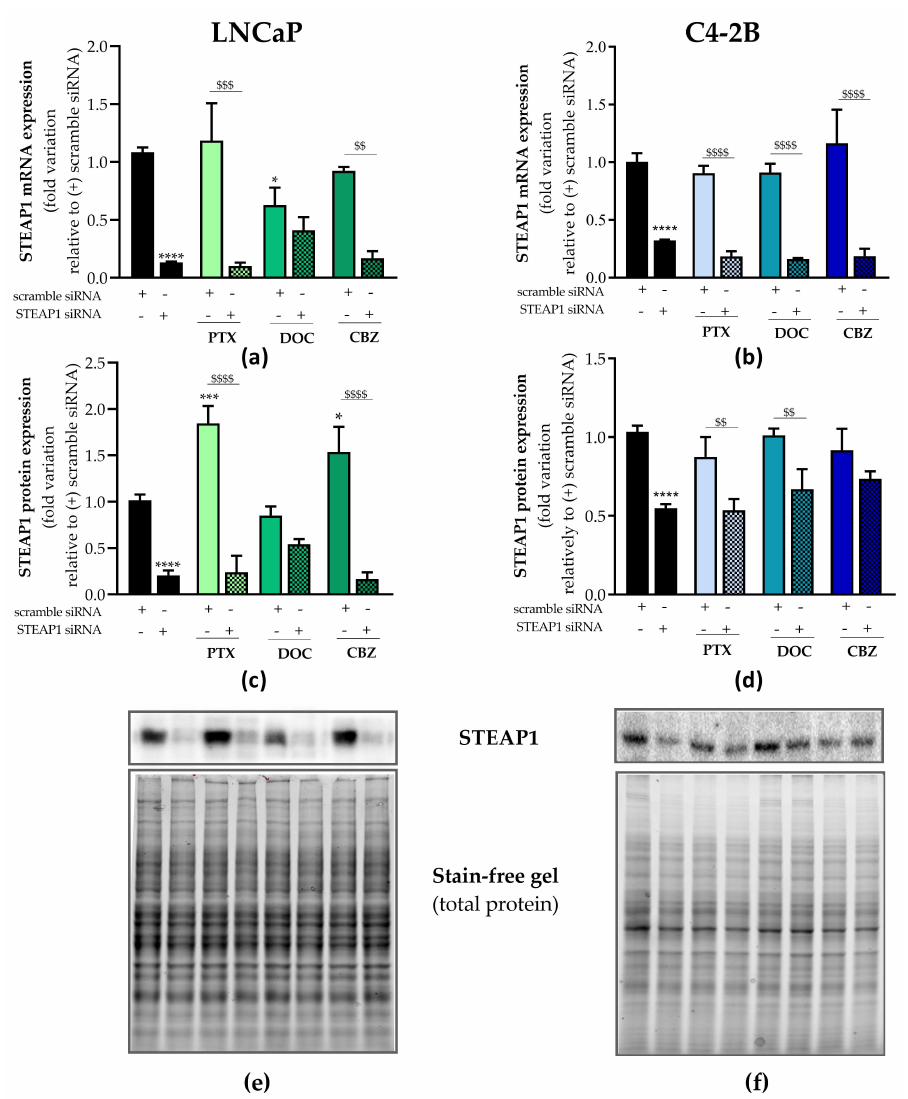
Figure 2. STEAP1 silencing in LNCaP and C4-2B cells and effect of taxane-based drugs on STEAP1 expression. Human neoplastic LNCaP and C4-2B prostate cells were transfected with scramble or STEAP1 small interfering RNA (siRNA) for 24 h and treated with 5 nM paclitaxel (PTX), 20 nM docetaxel (DOC) or 1 nM cabazitaxel (CBZ) for an additional 24 h. ( a , b ) Relative STEAP1 mRNA expression determined by RT-qPCR after normalization with the β 2M housekeeping gene. ( c , d ) Rela- tive STEAP1 protein expression determined by Western blot analysis after normalization with total protein. ( e , f ) SDS-PAGE gels’ representative image. The symbol “+” or “-“means presence or absence of the types of siRNA used in each experimental group. Results are represented as fold-variation in comparison to scramble siRNA (control group). Error bars show mean ± S.E.M (n ≥ 3). * p < 0.05, *** p < 0.001 and **** p < 0.0001 in comparison with the scramble siRNA group; and $$ p < 0.01, $$$ p < 0.001 and $$$$ p <